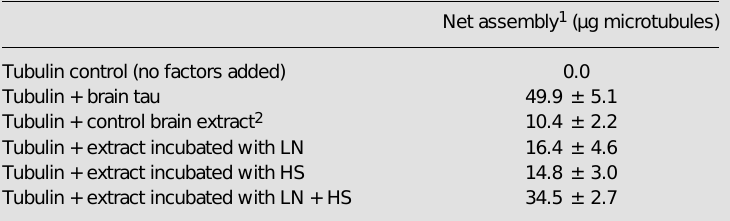
Table 2 - In vitro polymerization of tubulin in the presence of brain extracts of primary cultures of hippocampal cells. 1 Net assembly obtained after subtraction of the value of control for tubulin self- aggregation in the absence of any cell extract. Final concentration of proteins in the assembly system: 1.5 mg/ml tubulin; 0.14 mg/ml brain extracts. 2 Hippocampal cells in primary cultures were incubated under substrate control conditions, or in the presence of either ECM element. LN, Laminin; HS, heparan sulfate. Tubulin assembly was monitored by the sedimentation assay